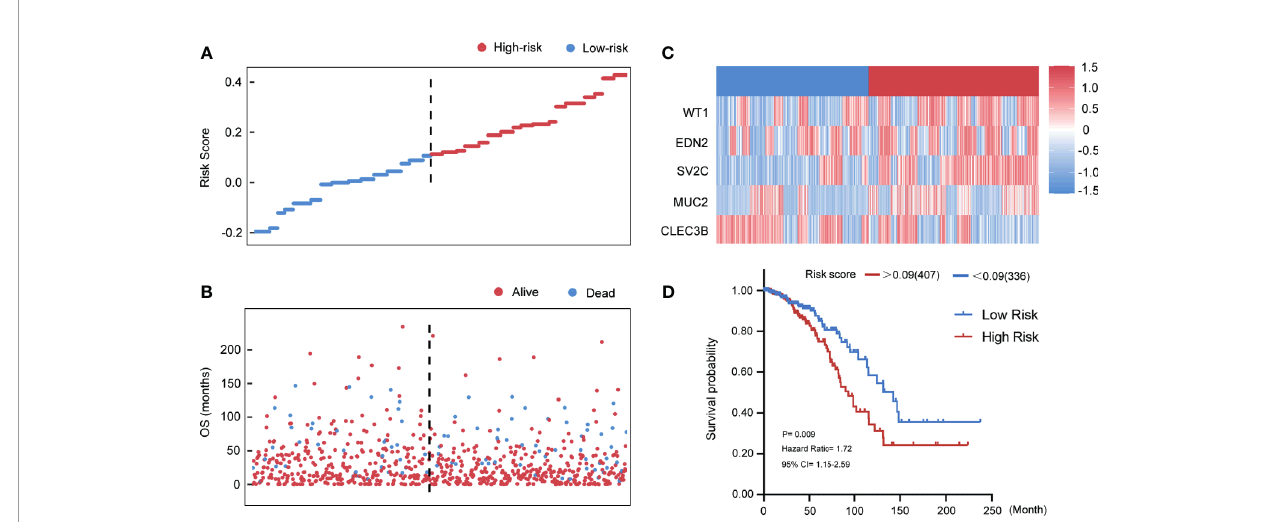
FIGURE 7 | Evaluating the predictive power of fi ve-gene signature in the entire group. (A) Distribution of risk score. (B) Survival status of breast cancer patients in the entire group. (C) Heatmap of the prognosis-associated gene expression pro fi les in the TCGA entire cohort. (D) Kaplan ‐ Meier plot of the high ‐ and low ‐ risk groups in the entire group.